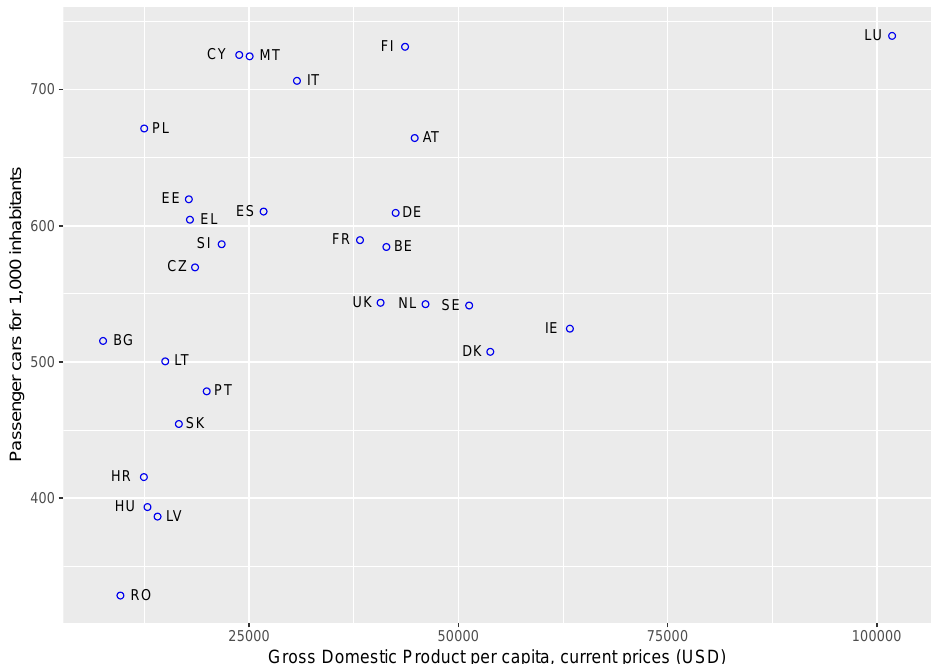
Figure 2. Scatter plot of the number of passenger cars per 1000 inhabitants versus the gross domestic product per capita, (current prices, in U.S. dollars) for European countries identified by their two-digit code. Data as of 2016. Source: authors’ own study on data from ACEA and